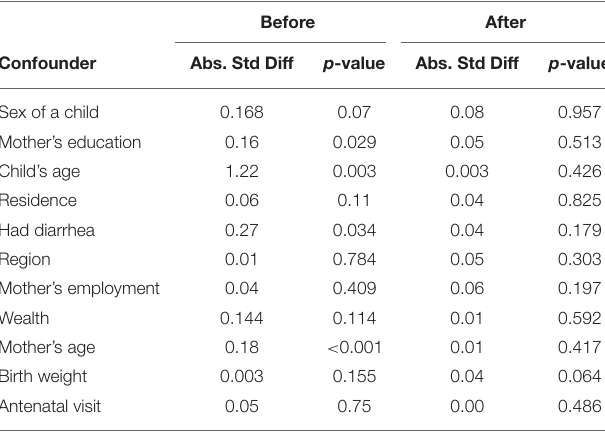
TABLE 5 | Absolute standard differences and p -values before and after application of propensity matching. Before After